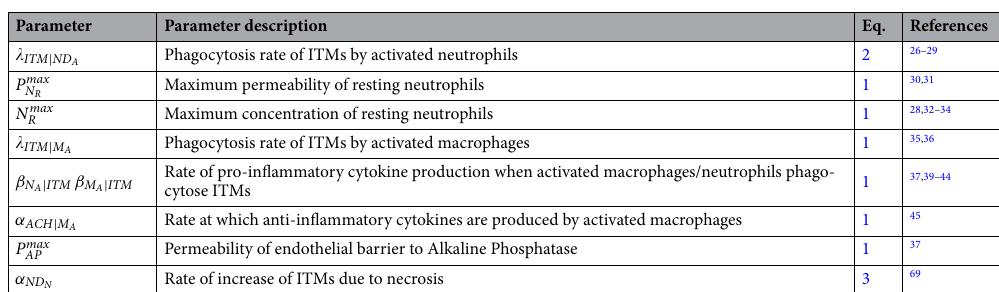
Table 3. Table of parameters adjusted in the human innate immune system